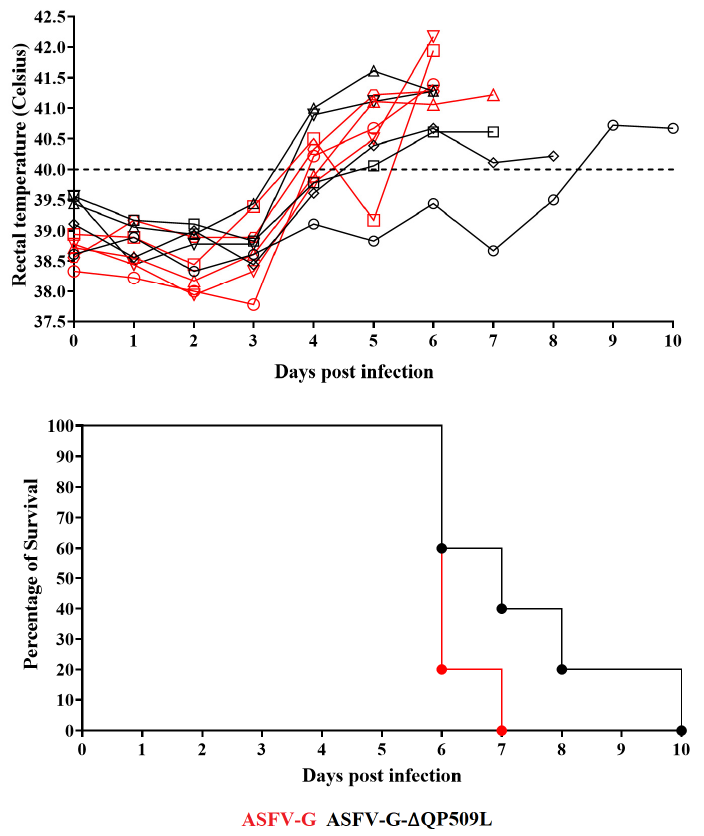
Figure 6. Evolution of body temperature and lethality in animals (five animals/group with each animal represented by a different shape) IM infected with 10 2 HAD 50 of either ASFV-G- ∆ QP509L or parental ASFV-G. After analyzing by both the Long-rank (Mantel-cox) and the Gehan-Breslow- Wilcoxon tests, no significant statistical differences were predicted between the different groups regarding their temperatures or lethality.